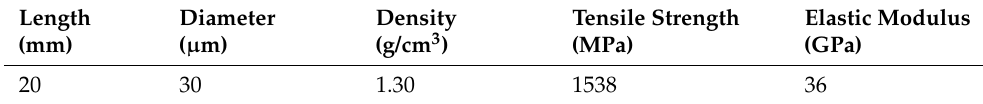
Table 2. Physical properties of PVA